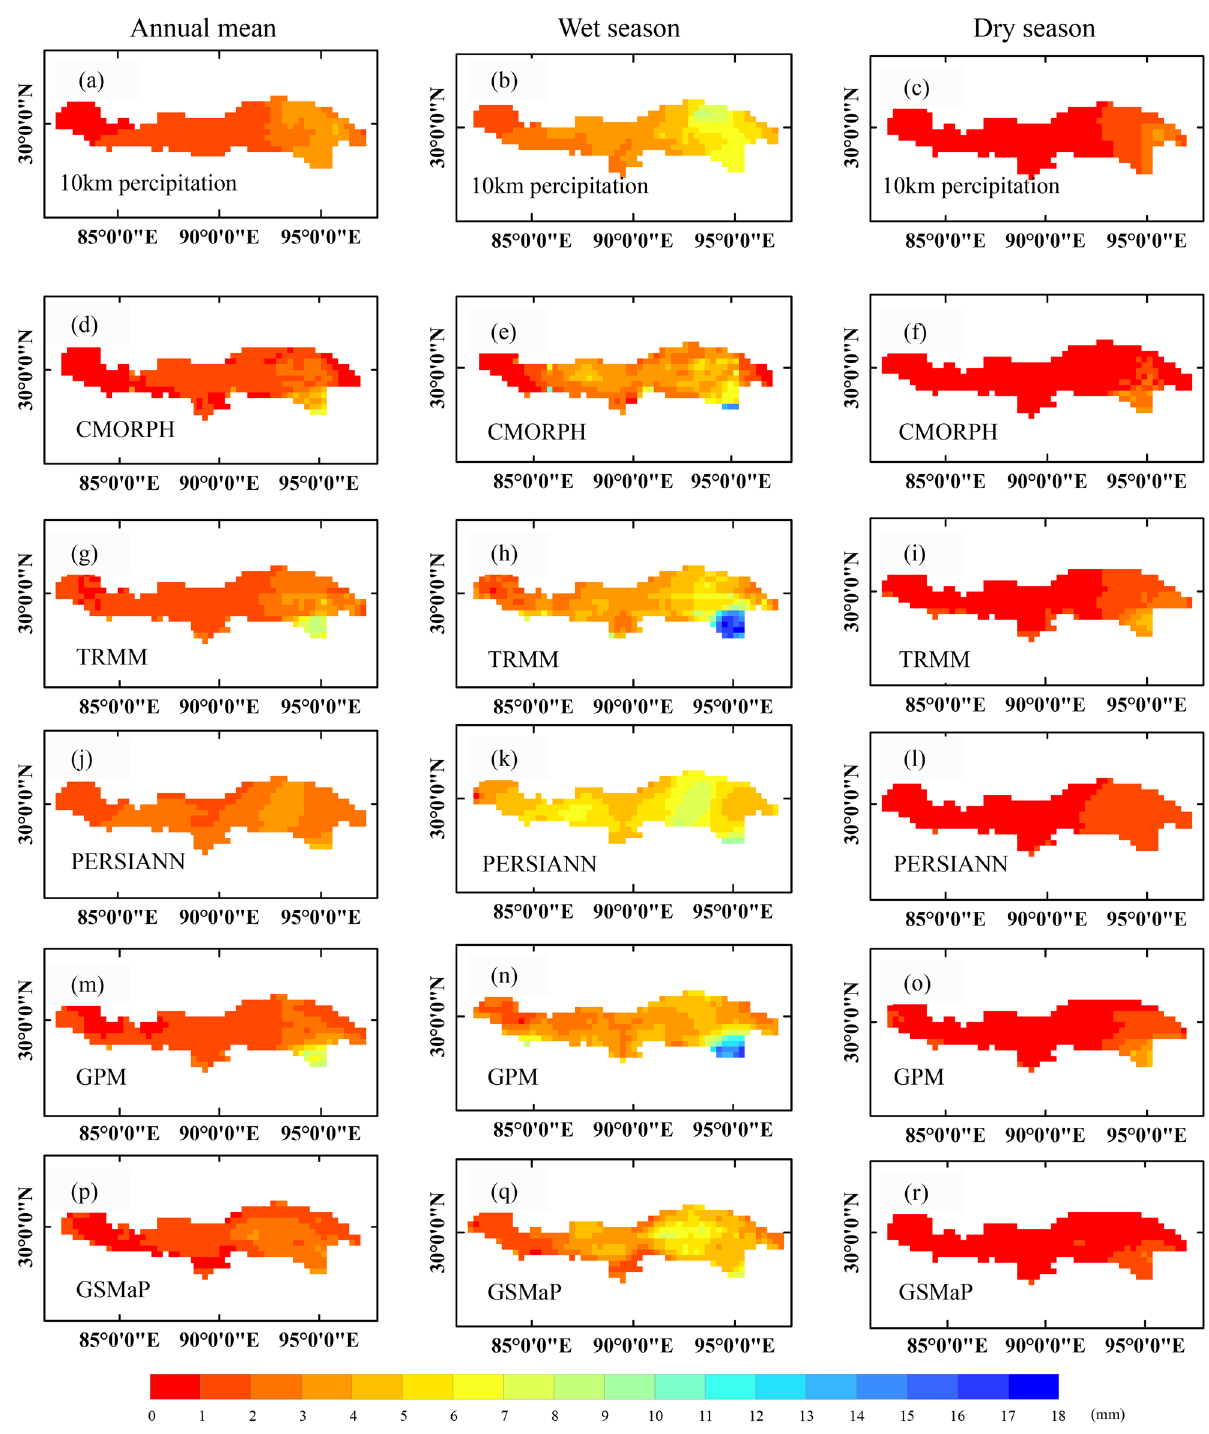
Figure 4. Spatial pattern of precipitation on multi-year timescale (left column), during wet seasons (middle column), and dry seasons in the YZRB during (Fig. 4j–l). The wet season didn’t appear a prominent precipitation patch in the southeast, while precipitation in most regions presented a higher range from 3 to 6 mm/day. In the annual and dry period, PERSIANN estimation demonstrated a basin-wide overestimation and an underestimation in the southern region, respectively. The GPM as the successor of TRMM exhibited identical good performance as TRMM compared with 10 km precipitation data (Fig. 4m–o), but there existed the precipitation patch in the corner of the southeast (Fig. 4m,n) in both the annual period and wet period. At the same time, in the dry season, the precipitation was underestimated in the northeast area. The GSMaP estimation showed a decreasing trend from east to west (Fig. 4p–r). Still, compared